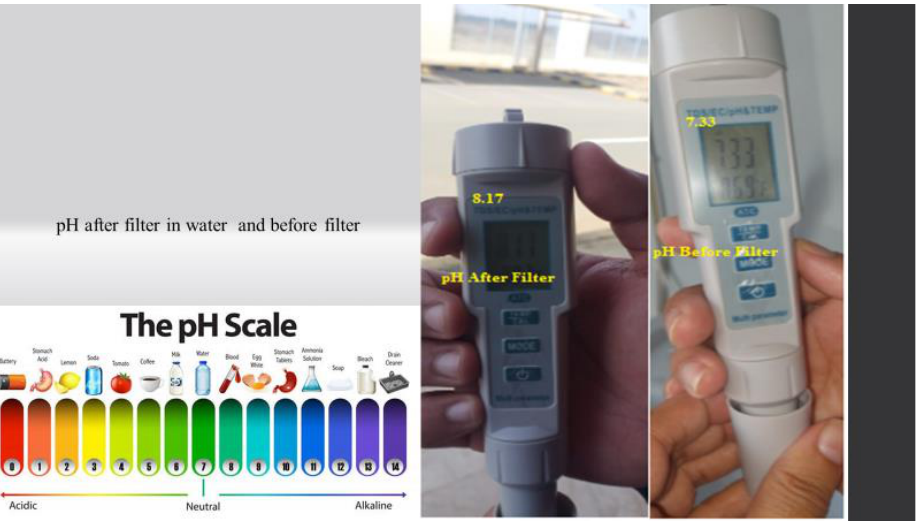
Figure 11. pH after filter and before